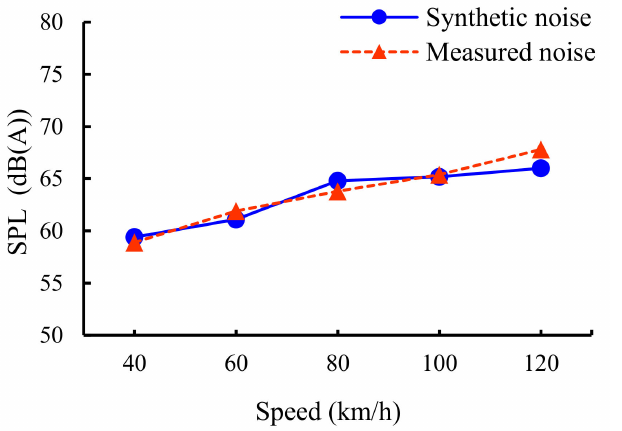
Figure 21. Comparison of synthetic and measured noise-sound pressure levels (SPL) at different operating speeds of the